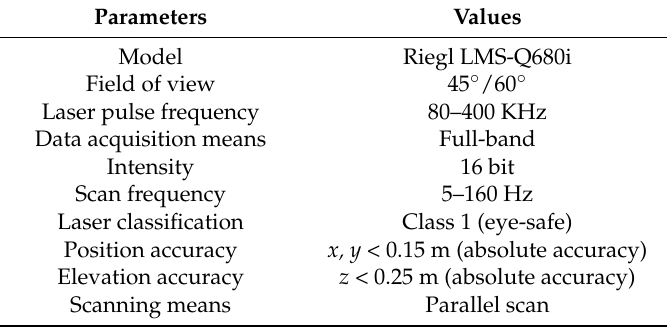
Table 1. Laser scanner parameters.